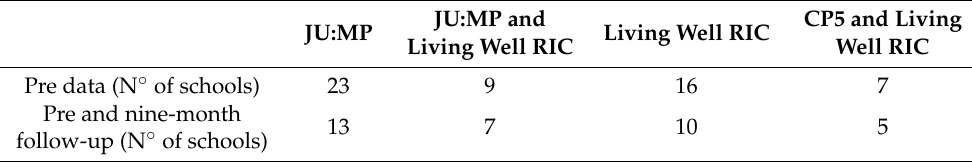
Table 1. The number of schools in the baseline and final data sample by programme. JU:MP and CP5 and Living JU:MP Living Well RIC Living Well RIC Well RIC Pre data (N ◦ of schools) 23 9 16 7 Pre and nine-month 13 7 10 follow-up (N ◦ of schools)